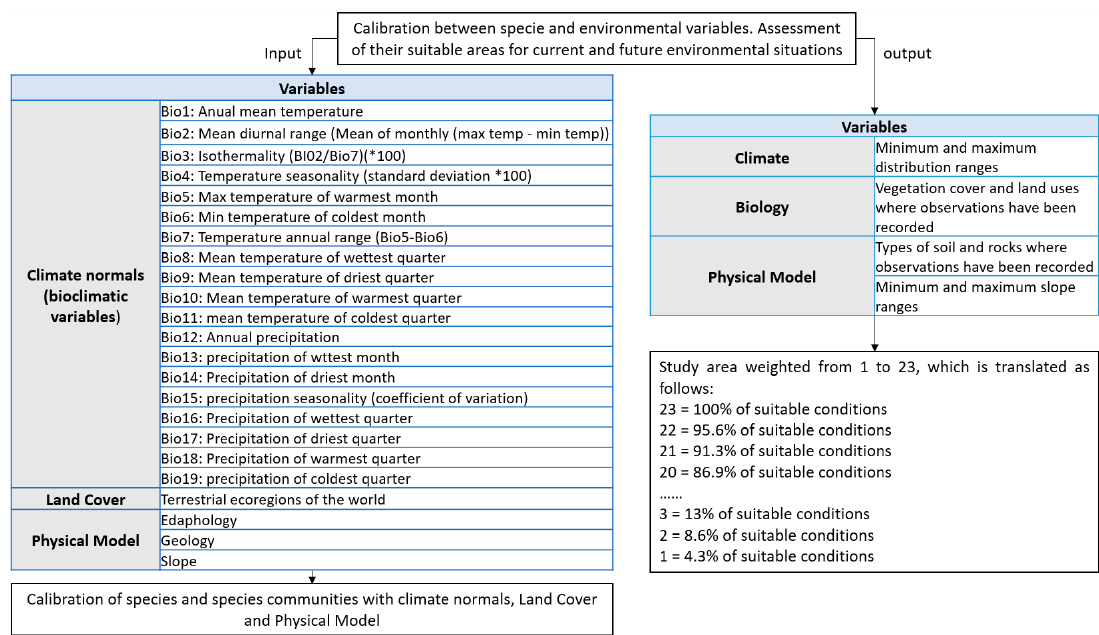
Figure 1. Data and steps related of CDS Toolbox SDM.